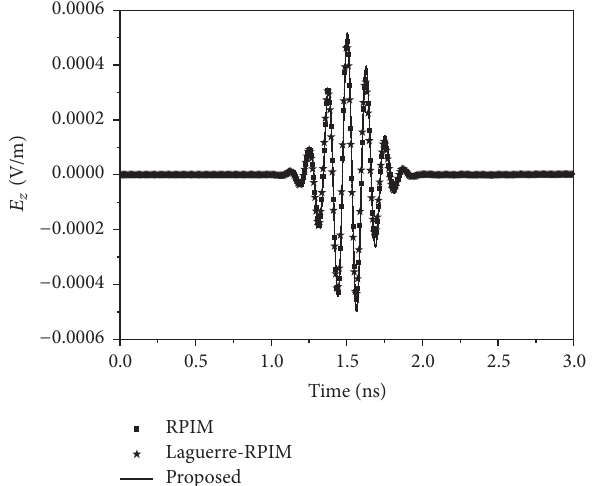
Proposed0.5 RPIM Laguerre-RPIM Figure 2: The electric field recorded at observation